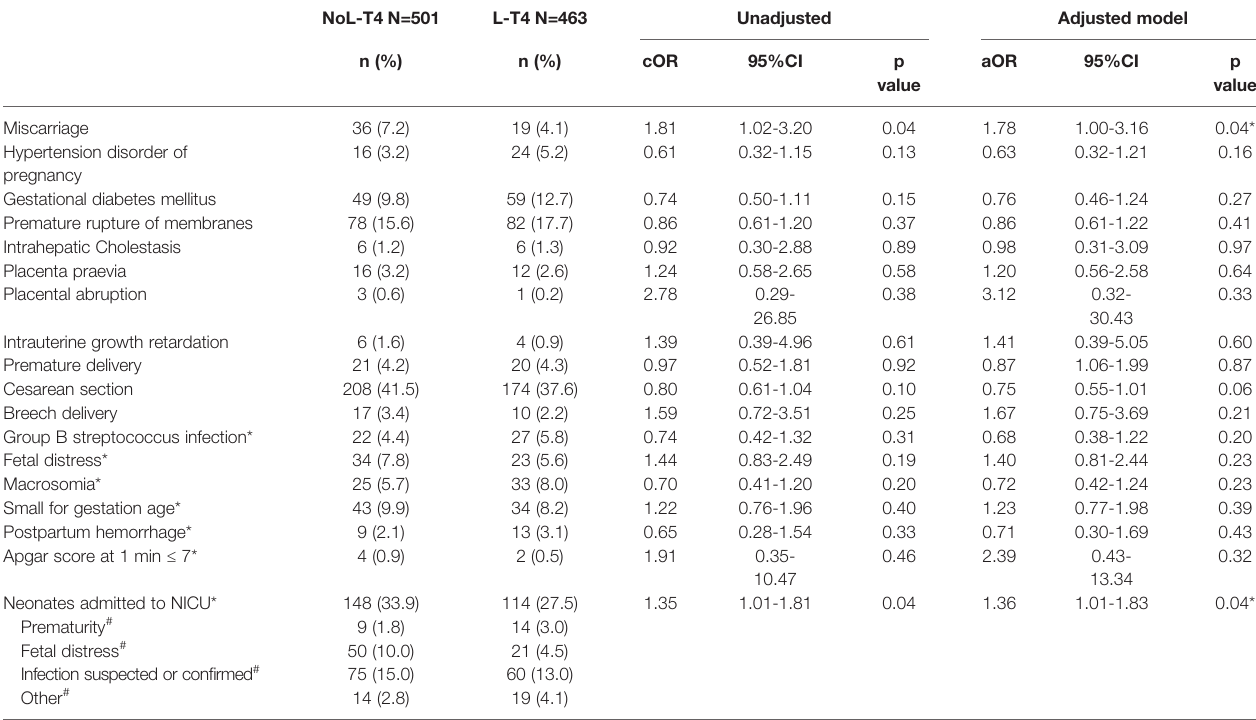
TABLE 2 | Adverse Pregnancy outcomes among pregnant women with hypothyroxinemia in the levothyroxine (L-T4) treatment group or controls. NoL-T4